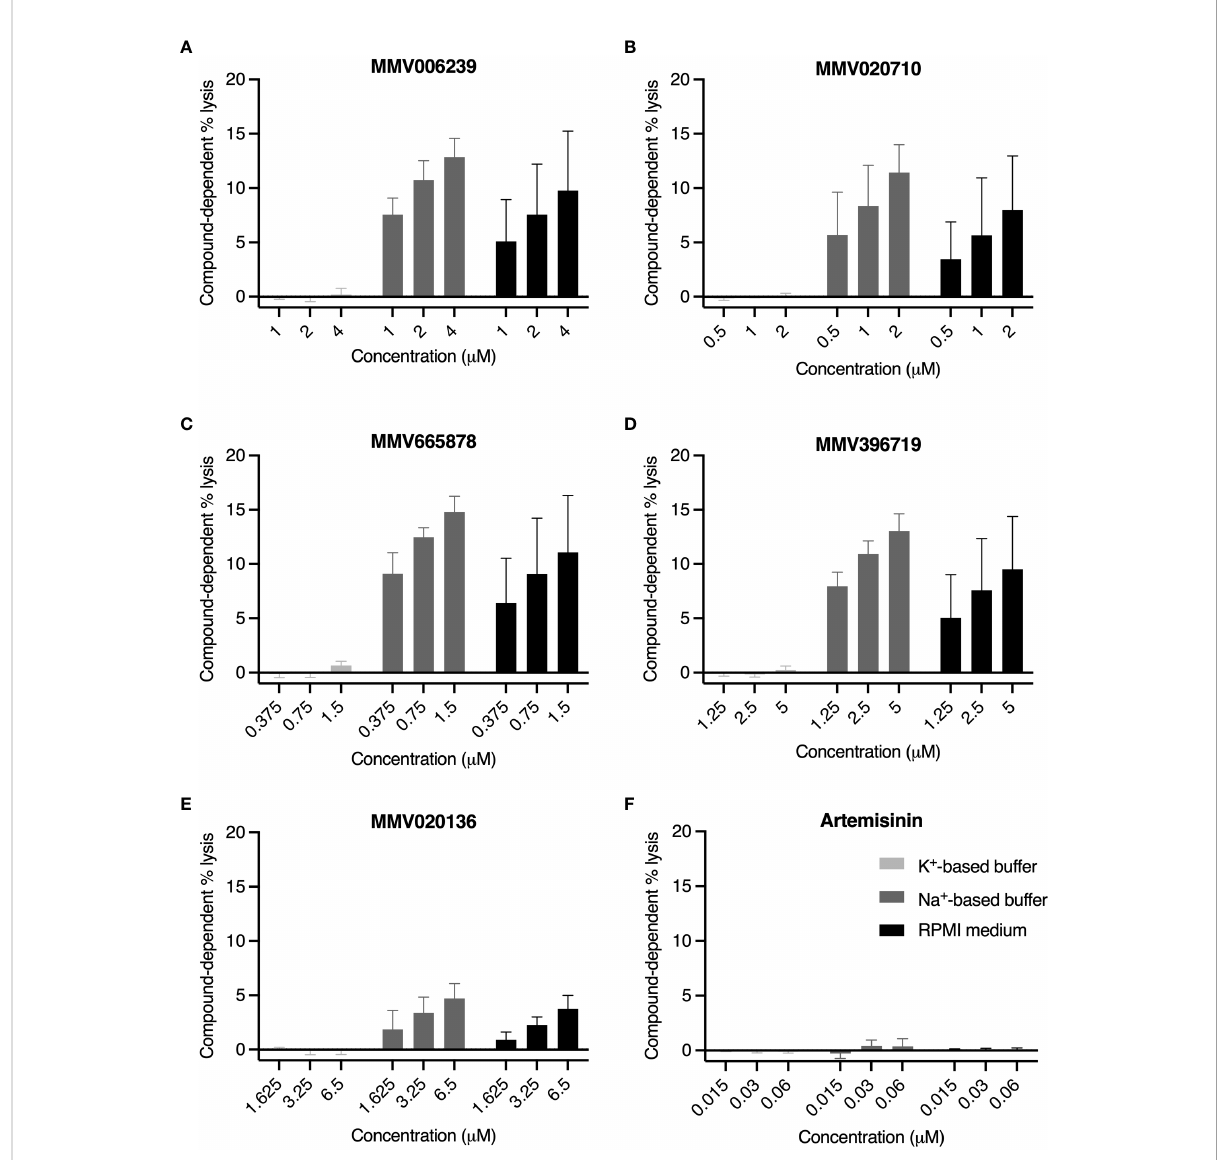
FIGURE 6 Pf ATP4 inhibitors induce Na + -dependent, concentration-dependent lysis of RBCs infected with 3D7_Hyp1-Nluc trophozoites. Trophozoites (~26-32 hpi) were resuspended in K + -based buffer (light grey bars), Na + -based buffer (dark grey bars) or standard RPMI medium (black bars). PfATP4 inhibitors (A – E) and the mechanistically unrelated antimalarial artemisinin (F) were diluted in the corresponding solutions and administered for 4 h at the concentrations speci fi ed ( m M), corresponding to ~5×IC 50 , ~10×IC 50 and ~20×IC 50 . Lysis was assessed by measuring the bioluminescent signal intensity of nanoluciferase released into the cell-free growth medium and expressing this as a percentage of the signal intensity of the total culture (cells and medium, with host and parasite cells chemically lysed). Compound-dependent lysis was then estimated by subtracting the percentage lysis measured in wells treated with the DMSO vehicle control. Graphs indicate the mean ± SD compound-dependent percentage lysis of four biological replicates, each consisting of technical duplicates or